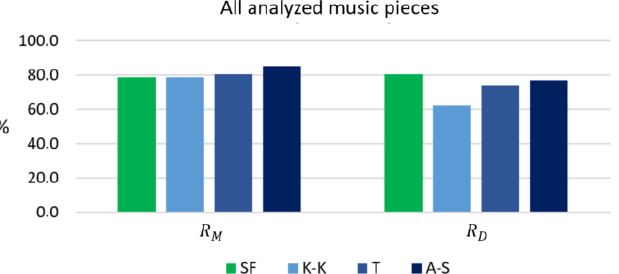
Figure 15. The overall key-finding efficacies obtained for all the considered music pieces, corre- sponding to the shortest initial fragments of music for which the key was indicated in all the exam- ined approaches, where 𝑅 𝑀 — the multiplicities of occurrences of individual pitch-classes, 𝑅 𝐷 — the aggregate durations of individual